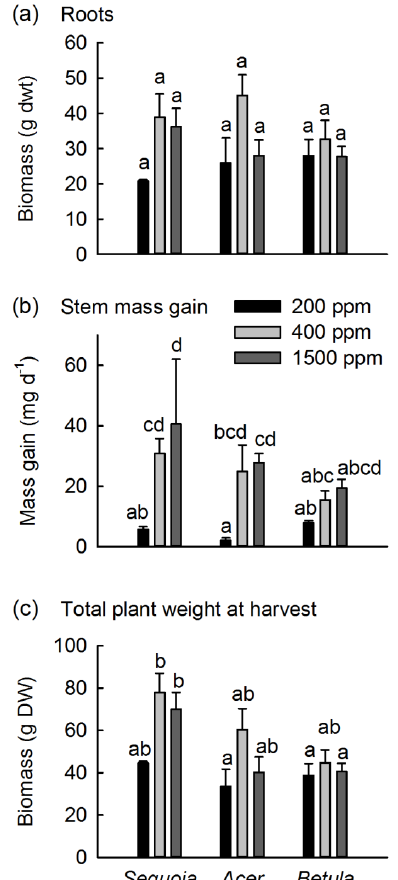
Fig. 5. Numerical simulations of [CO 2 ] a -regulated mycorrhizal fun- gal weathering. (a) Simulated [CO 2 ] a -regulated total Ca and Mg Fig. 4. Sapling biomass after the experiment. Root biomass (a) , cal- weathering flux from basalt by AM and EM fungal networks be- Figure 5. Numerical simulations of [CO 2 ] a -regulated mycorrhizal fungal weathering. (a) Figure 4. Sapling biomass after the experiment. Root biomass (a), calculated stem mass culated stem mass gain (b) (a proxy for net primary production) neath each tree over the 185 day experiment (note the axis break). Simulated [CO 2 ] a -regulated total Ca and Mg weathering flux from basalt by AM and EM and measured total plant biomass (c) at the end of the experiment. gain (b) (a proxy for net primary production) and measured total plant biomass (c) at the end (b) Simulated release of Si from basalt by the hyphosphere and bulk fungal networks beneath each tree over the 185 day experiment (note the axis break). (b) Values are mean ± SEM ( n = 3). Bars sharing the same letter are solution interactions for trees versus calculated pH, compared with of the experiment. Values are mean ± s.e.m ( n = 3). Bars sharing the same letter are not Simulated release of Si from basalt by the hyphosphere and bulk solution interactions for not statistically different at P < 0 . 05 (two-way ANOVA testing for Si release rates and pH values from field and laboratory studies of statistically different at P < 0.05 (two-way ANOVA testing for effects of species and [CO 2 ] a trees versus calculated pH, compared with Si release rates and pH values from field and effects of species and [CO 2 ] a with Tukey multiple comparisons). basalt weathering (Navarre-Sitchler and Brantley, laboratory studies of basalt weathering (Navarre-Sitchler and Brantley, 2007). with Tukey multiple comparisons).